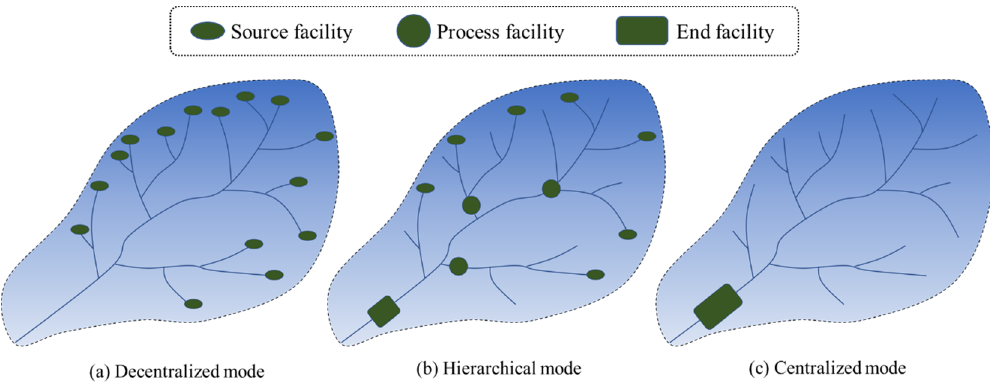
Figure 8. Locations and combined patterns of GI at the watershed scale.